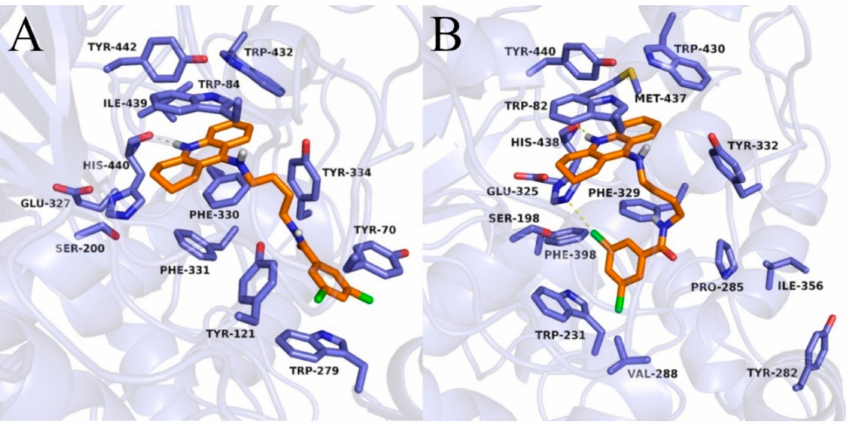
Figure 6. Binding mode of compound 3c within acetylcholinesterase ( A ) and butyrylcholinesterase ( B